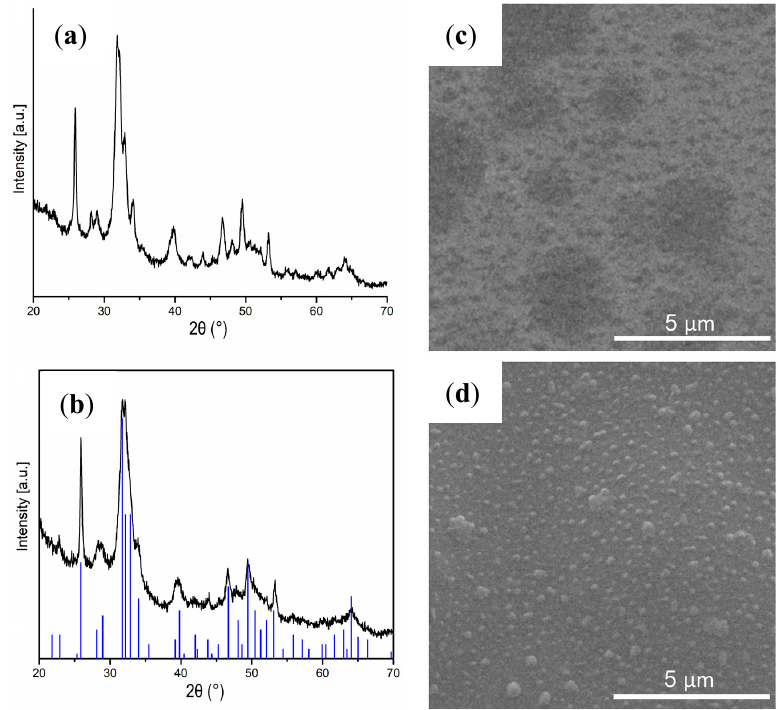
Figure 9. X-ray diffraction (XRD) diffractogram and SEM micrograph of HAp ( a , c ) and 5SmHAp Figure 9. X-ray di ff raction (XRD) di ff ractogram and SEM micrograph of HAp ( a , c ) and 5SmHAp coatings ( b , d ). coatings ( b , d ). Coatings 2020 , 10 , x FOR PEER REVIEW 13 of 24